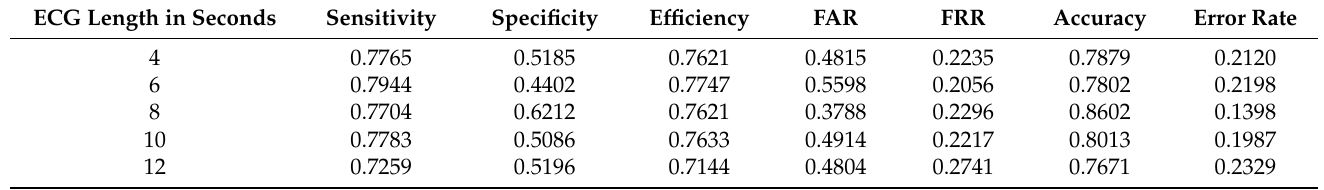
Table 3. The proposed method experimental results with the original Fast Fourier Transform (FFT) method. ECG Length in